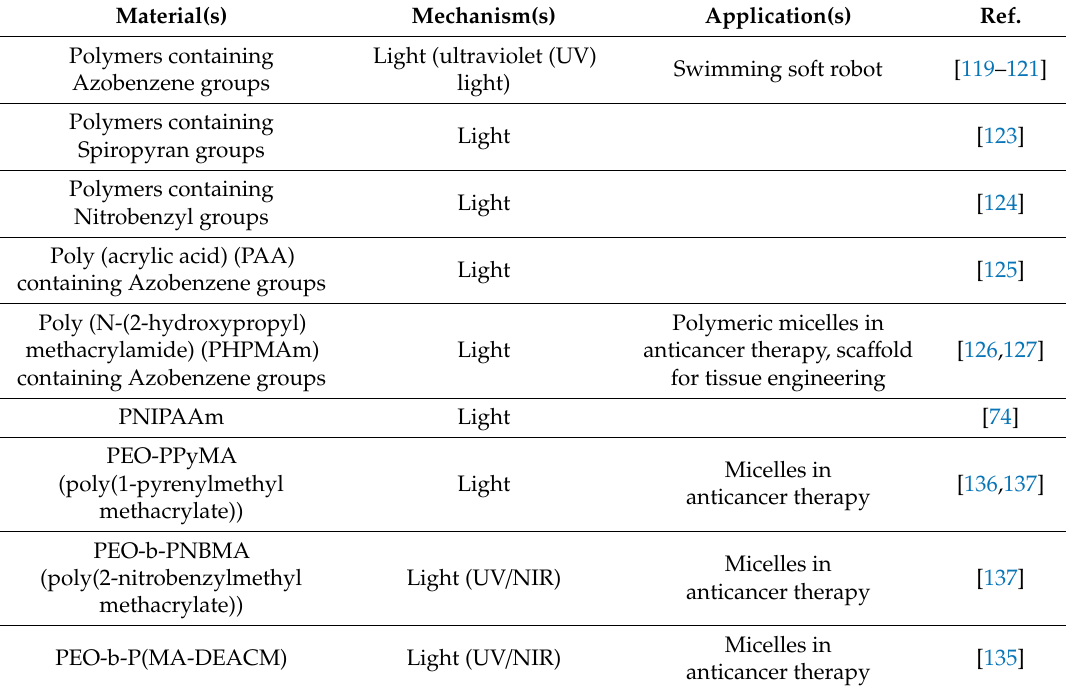
Table 5. Overview of the experiments on 4D (bio-)printing and other manufacturing approaches using light as a predefined